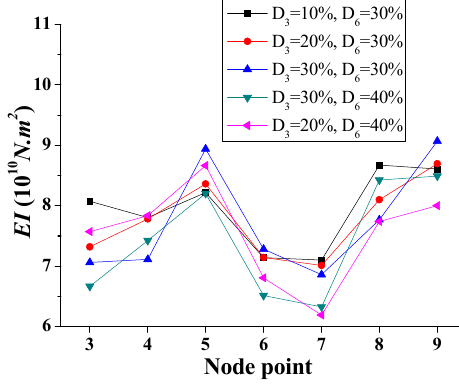
Figure 10. EI variation ratios for a single damage (Scenario 1). ( a ) Ratio with respect to calculated undamaged EI . ( b ) Ratio with respect to specified undamaged EI .